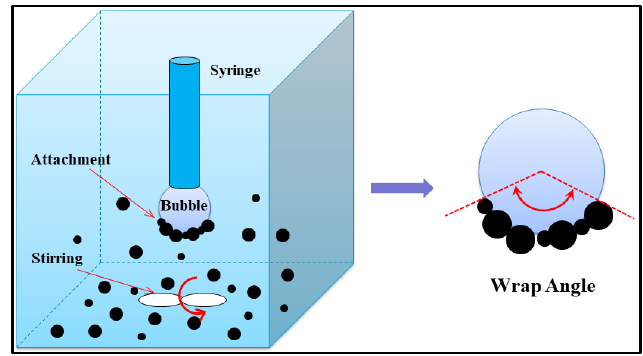
Figure 2. Schematic of bubble-particle wrap angle experiment [24, Reproduced with permission from Xia Y., Fuel; published by Elsevier, 2019].